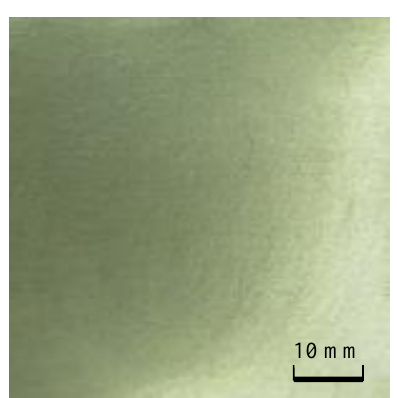
Figure 4. Sketch of photo-sensory membrane.